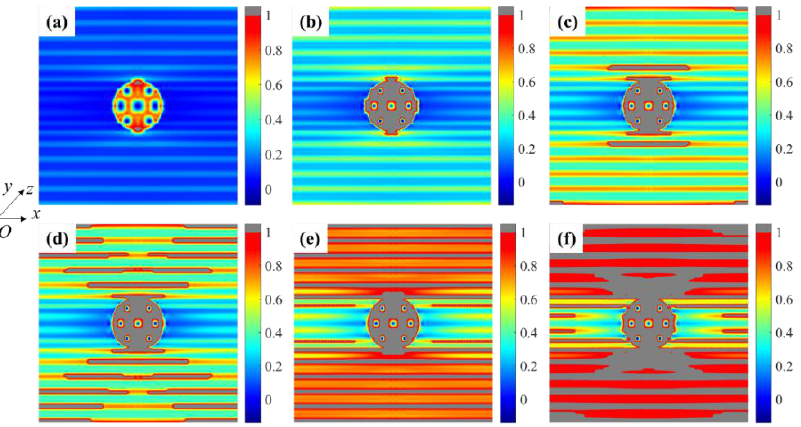
Figure 10. Damage evolution of the needling region in 0° unidirectional fiber ply ( a ) damage initiation ( b ) needling hole failure ( c ) matrix damage on both sides of the hole ( d ) failure of matrix between unidirectional fibers begins ( e ) complete failure of the matrix ( f ) fibers failure.